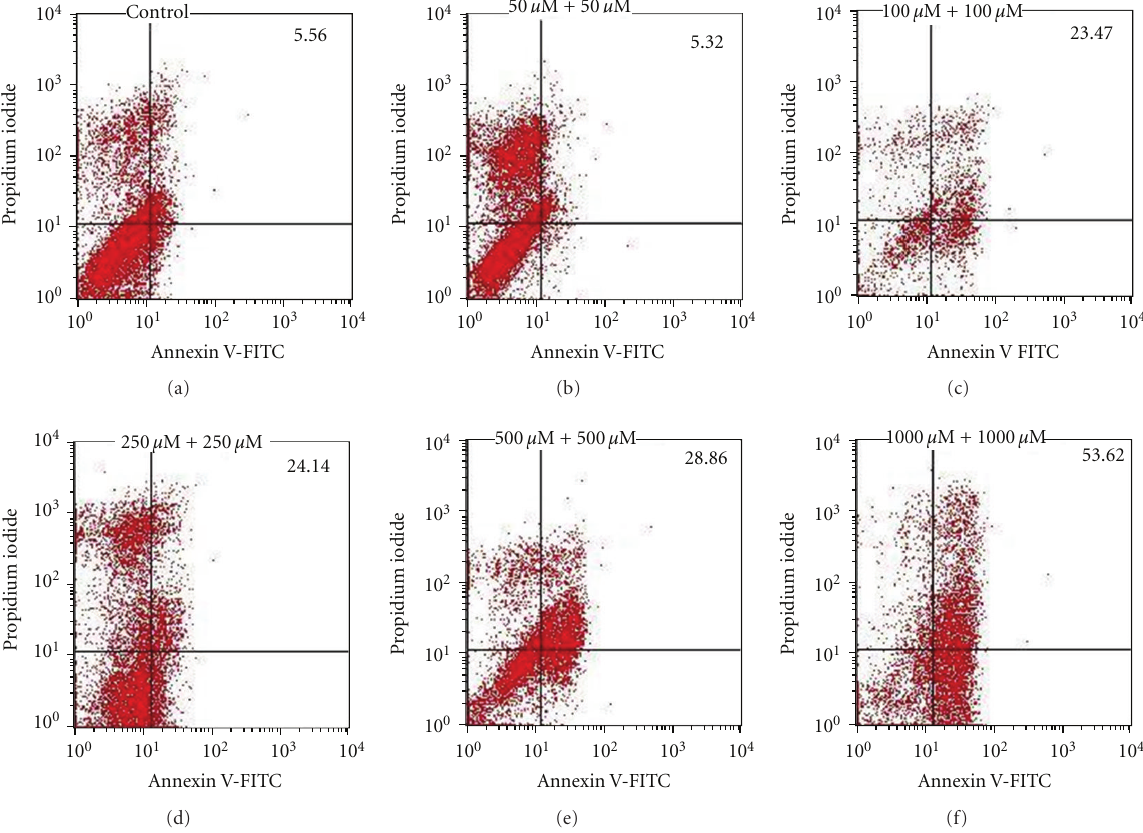
Figure 4: Flow cytometric analysis of apoptosis of coadministration of piroxicam and deracoxib on canine mammary carcinoma cell line after 72h incubation. The lower left quadrant of the histogram shows the viable cells, which exclude PI, and are negative for FITC-Annexin- V-binding FITC − /PI − (LL). The lower right compartment represents the early apoptotic cells, which are PI negative and Annexin-V positive, indicating the translocation of phosphatidylserine to the external cell surface FITC + /PI − (LR). The upper right quadrant represents the late- stage apoptotic cells which are PI and Annexin-V positive FITC + /PI + (UR), and the upper left compartment shows the necrotic cells which are only PI positive FITC − /PI + (UL). The numbers written on histograms represent the sum of early and late apoptotic cells (%).